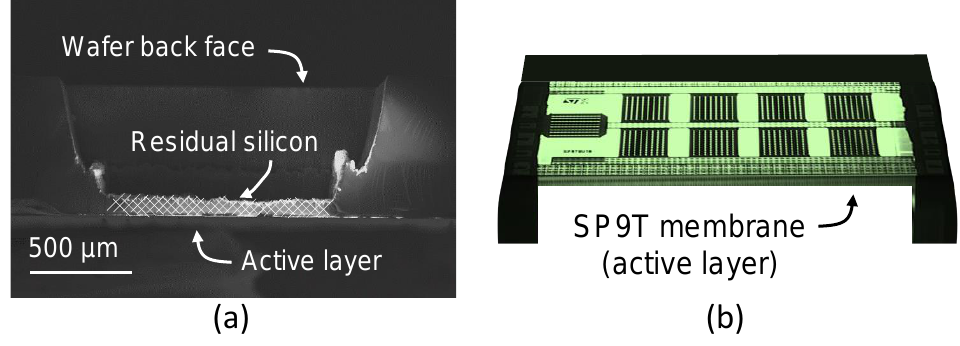
Figure 9. ( a ) SEM cross-sectional image of cavity fabricated using laser processing. The hatched zone corresponds to residual silicon left after laser processing and before XeF 2 selective etching; ( b ) 3D rendered backlight illuminated optical microscope